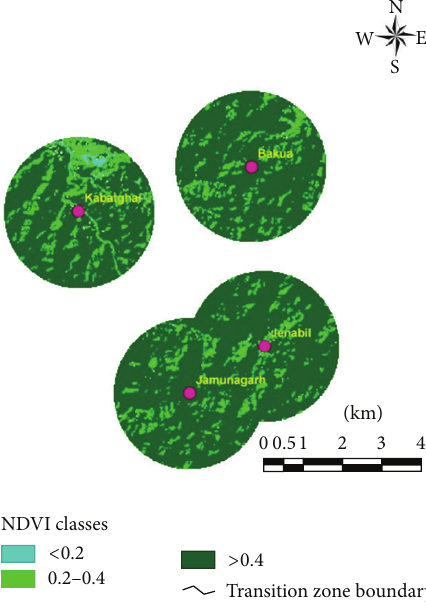
Figure 6: Vegetation density map in terms of NDVI classes in 5 km buffer area surrounding Bakua, Jenabil, Jamunagarh, and Kabatghai villages in SBR for 2005.